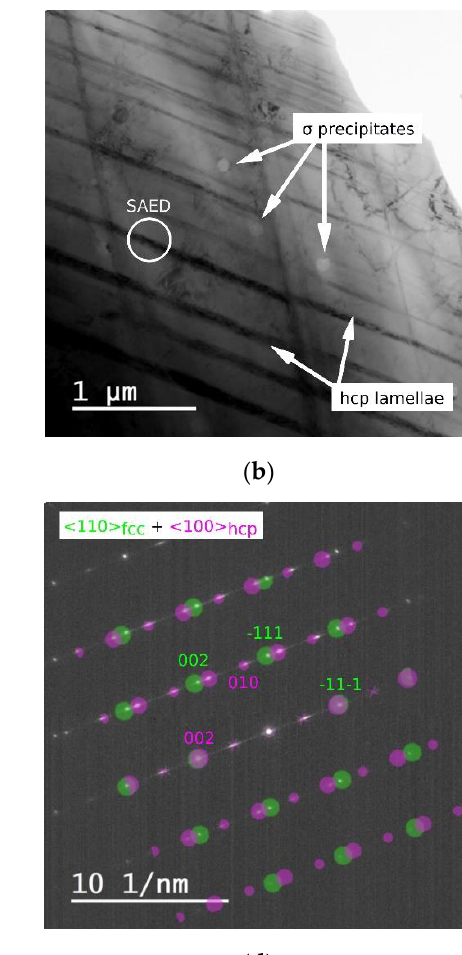
Figure 2. Chemical composition inside cells and in the intercellular network.